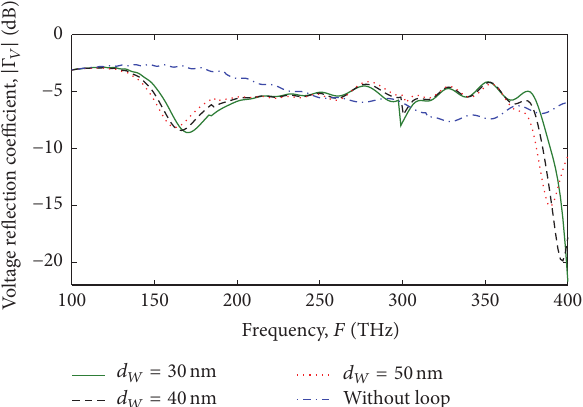
Without Figure 23: Voltage reflection coefficient (|Γ 𝑉 |) with the loop near Figure 22: Voltage reflection coefficient (|Γ 𝑉 |) with the loop near the the dipole for different values of 𝑑 𝑊 (30, 40, and 50 nm) with 𝑑 𝐻 = dipole for different values of 𝑑 𝑊 (30, 40, and 50 nm) with 𝑑 𝐻 = 10 nm 20 nm and also |Γ 𝑉 | without the and also |Γ 𝑉 | without the loop.